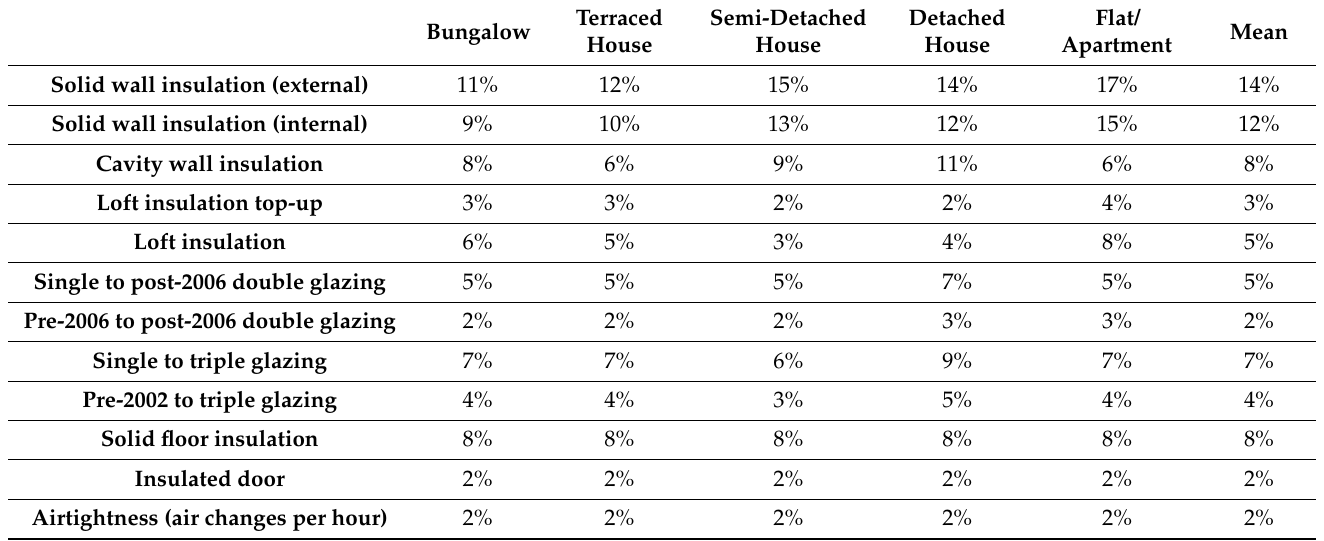
Table 2. Percentage reduction in demand due to different retrofit measures according to current building standards. Terraced Semi-Detached Detached Flat/ Bungalow House House House